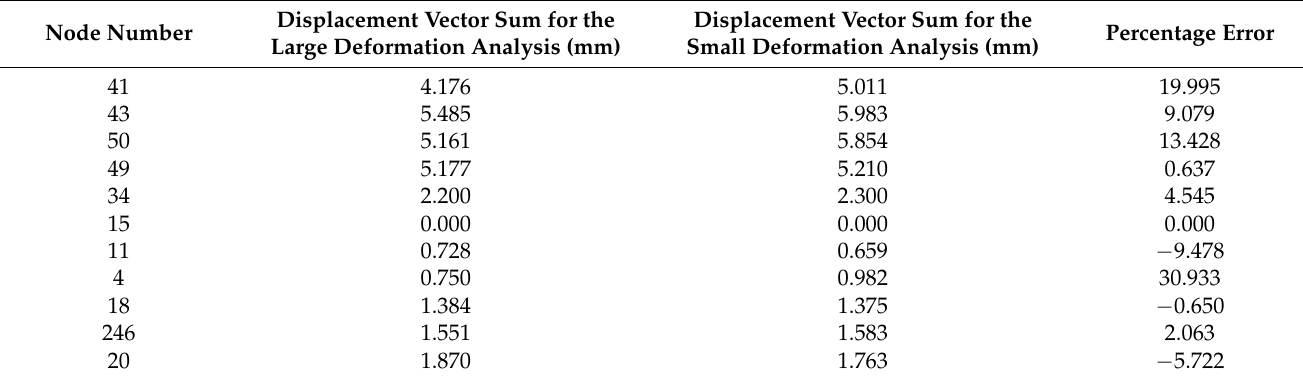
Table 1. Percentage Errors for Problem 1.